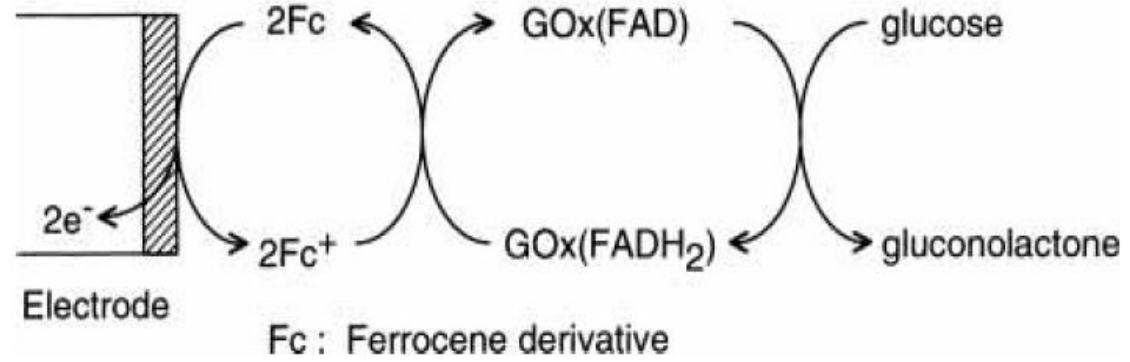
Figure 1. Ferrocene (Fc)-mediated electron transfer in amperometric glucose